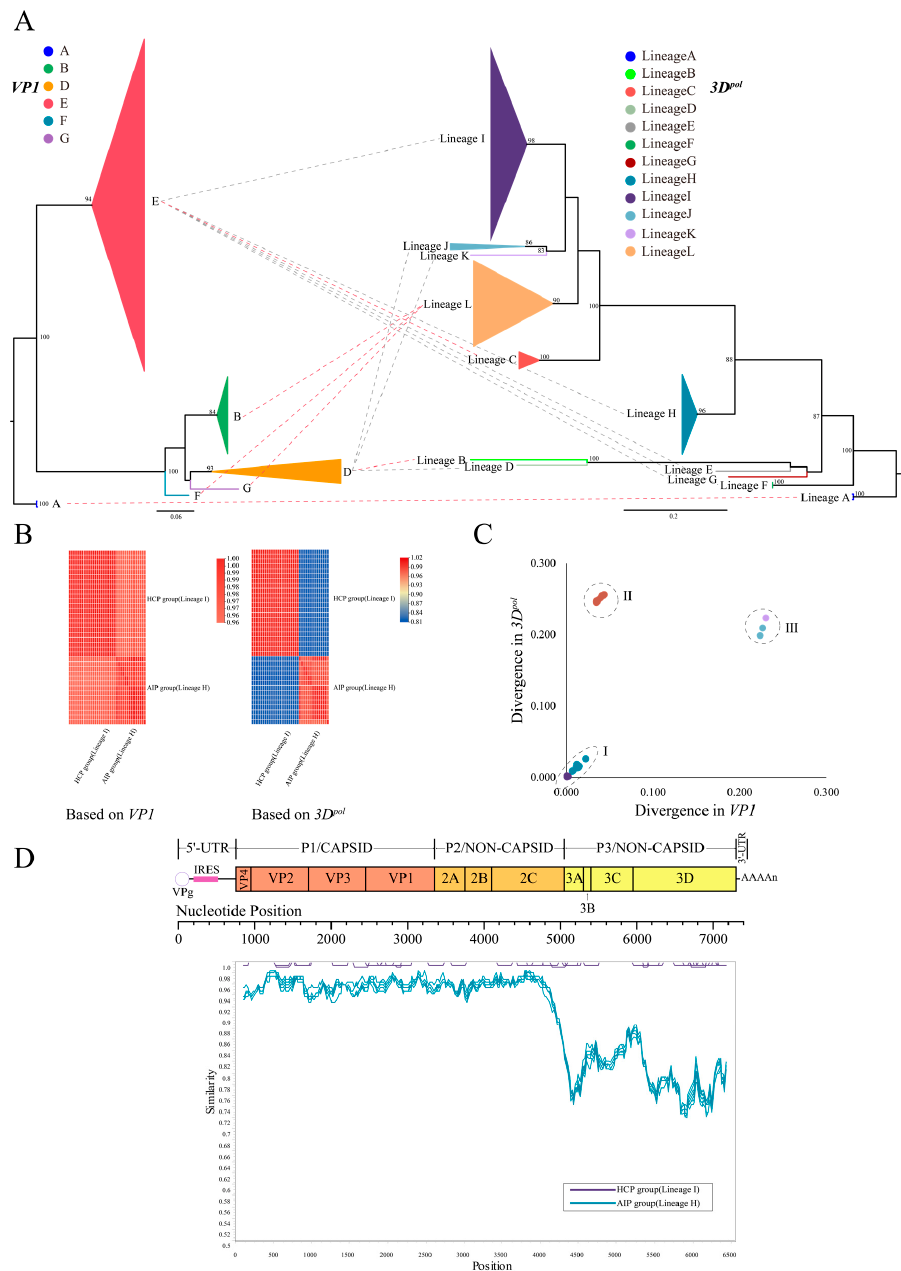
Figure 1. Phylogenetic analysis of CVB4. ( A ) The left and right are the ML tree based on VP1 regions of 80 CVB4 sequences and 3D pol regions, respectively. Sequences with the same genotype/lineage merged into a triangle, had a size proportional to the number of sequences, and different colors were used to distinguish the different genotypes/lineages. ( B ) Nucleotide similarity heatmap of CVB4 sequences of AIP and HCP groups. The left and right were constructed based on VP1 and 3D pol sequences, respectively. ( C ) Pairwise distance comparisons of VP1 and 3D pol sequences, (I) shows the comparison of the CVB4 sequences isolated from AIP and HCP groups in their respective intra-lineage sequences, (II) between CVB4 isolated from AIP and HCP groups, and (III) between lineage -J, -K, and CVB4 isolated from HCP group. ( D ) Similarity comparisons between CVB4 sequences isolated from AIP and HCP groups using sliding window nucleotide similarity analysis, with 200 nucleotide windows moving in steps of 20 nucleotides. We used green lines to represent all sequences isolated from asymptomatic infected persons (AIP group), and purple lines to represent all sequences isolated from clinical patients with HFMD (HCP